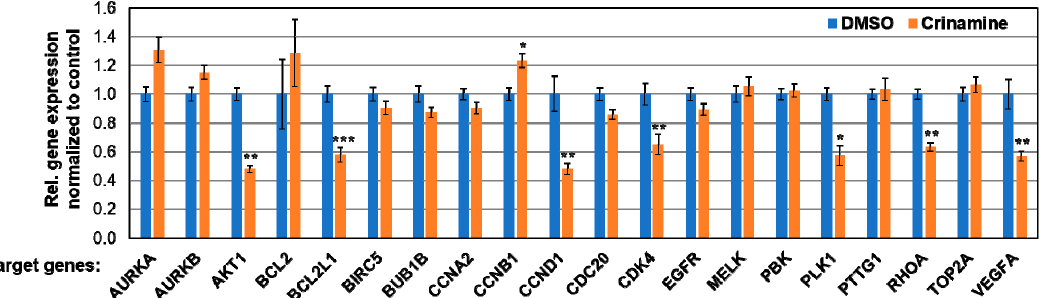
Figure 6. E ff ect of crinamine on mRNA expression of selected cervical cancer-related genes. SiHa cells were treated with DMSO or 12 µ M crinamine for 8 h. Gene expression analysis was assessed by RT-qPCR. Expression levels were normalized internally to PGK1, RPS13, and U6 snRNA, and externally to the DMSO control. Bars indicate the mean ± SD from duplicate measurements. * p < 0.05; ** p < 0.01; *** p < 0.001.